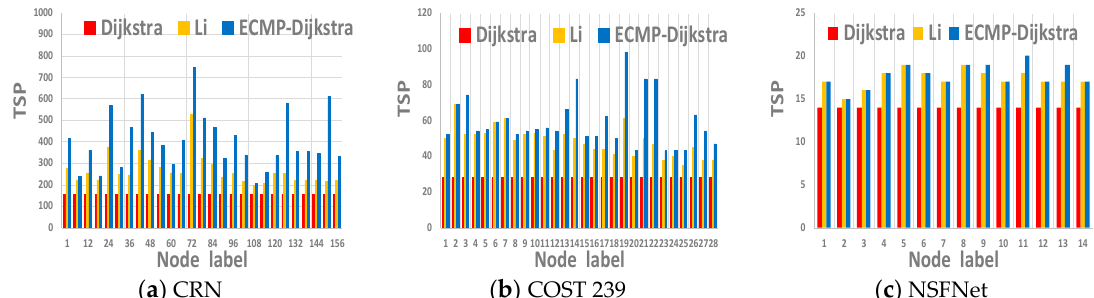
Figure 1. The impact of three shortest path algorithm on TSP in three topologies. TSP. The higher, the better.